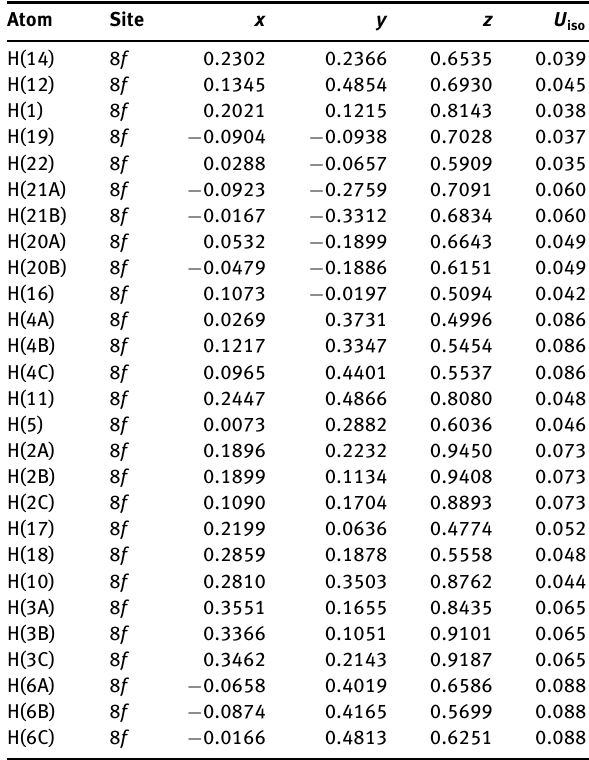
Table 2: Fractional atomic coordinates and isotropic or equivalent isotropic displacement parameters (Å 2